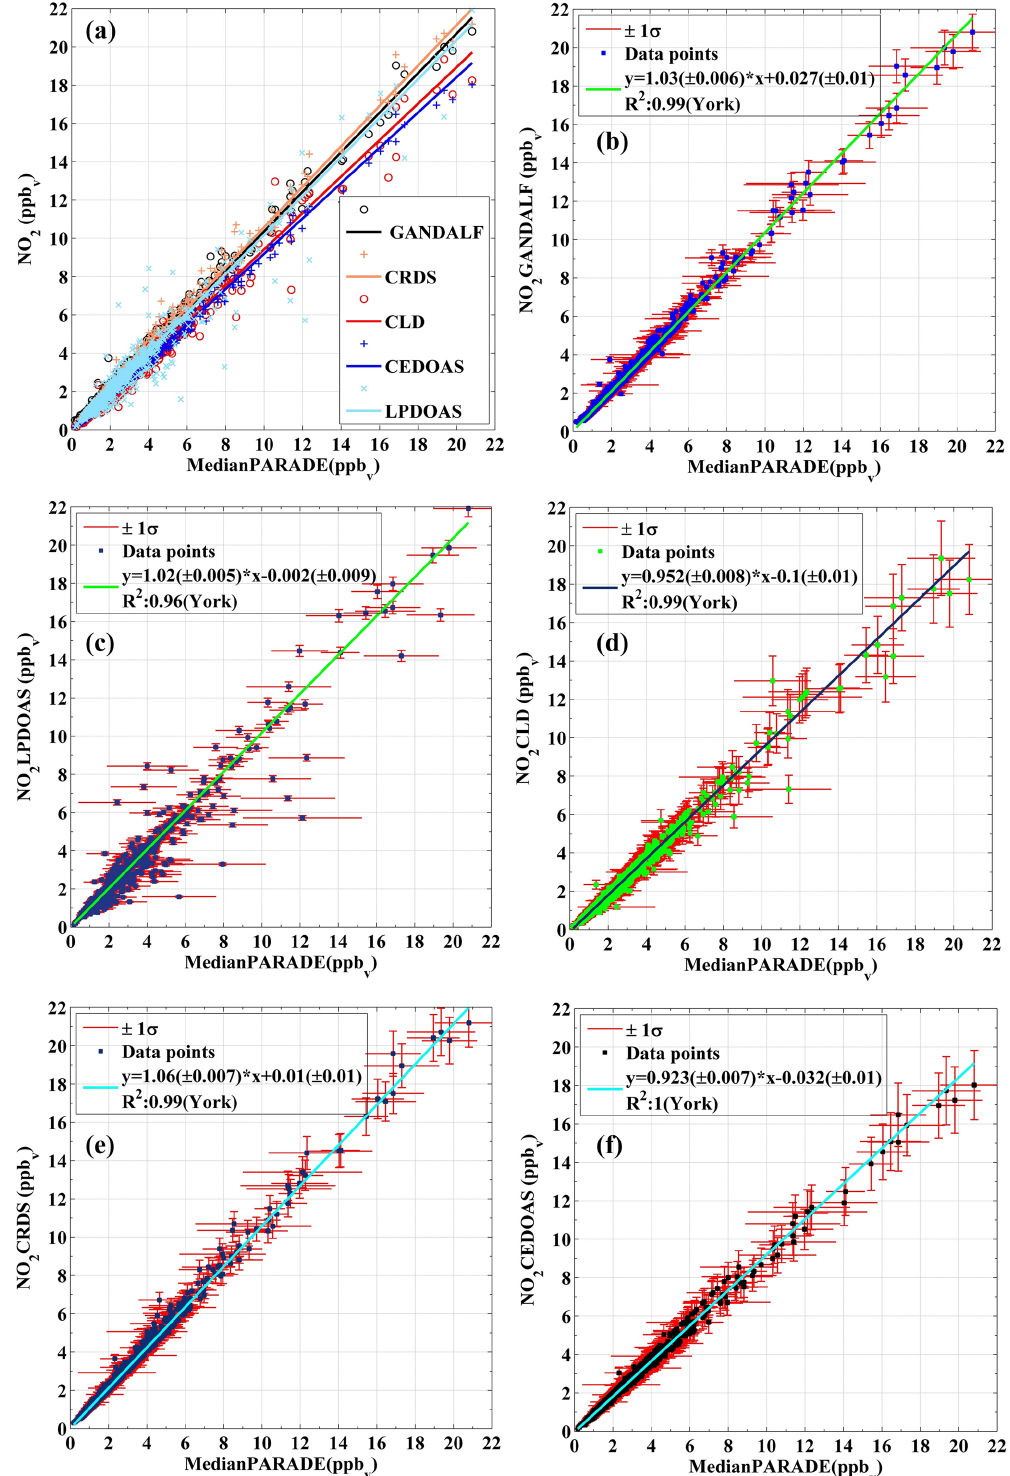
Figure 10. Correlation plots of individual NO 2 measurement vs. the derived median values of all NO 2 measurement at the platform during PARADE. (a) Overall, (b) GANDALF, (c) CLD, (d) CRDS, (e) LP-DOAS, and (f)